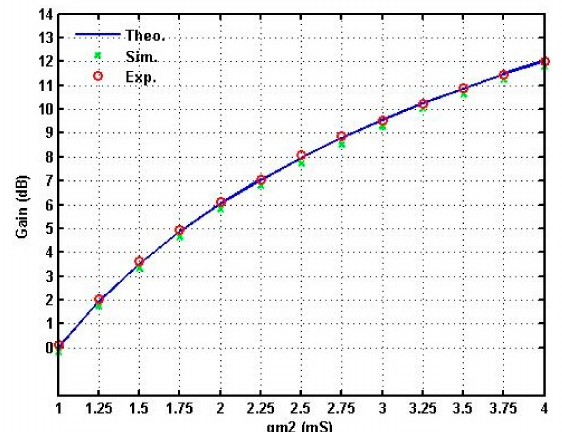
Figure 30. The measured magnitude responses of the V BP6 when R 5 was varied.